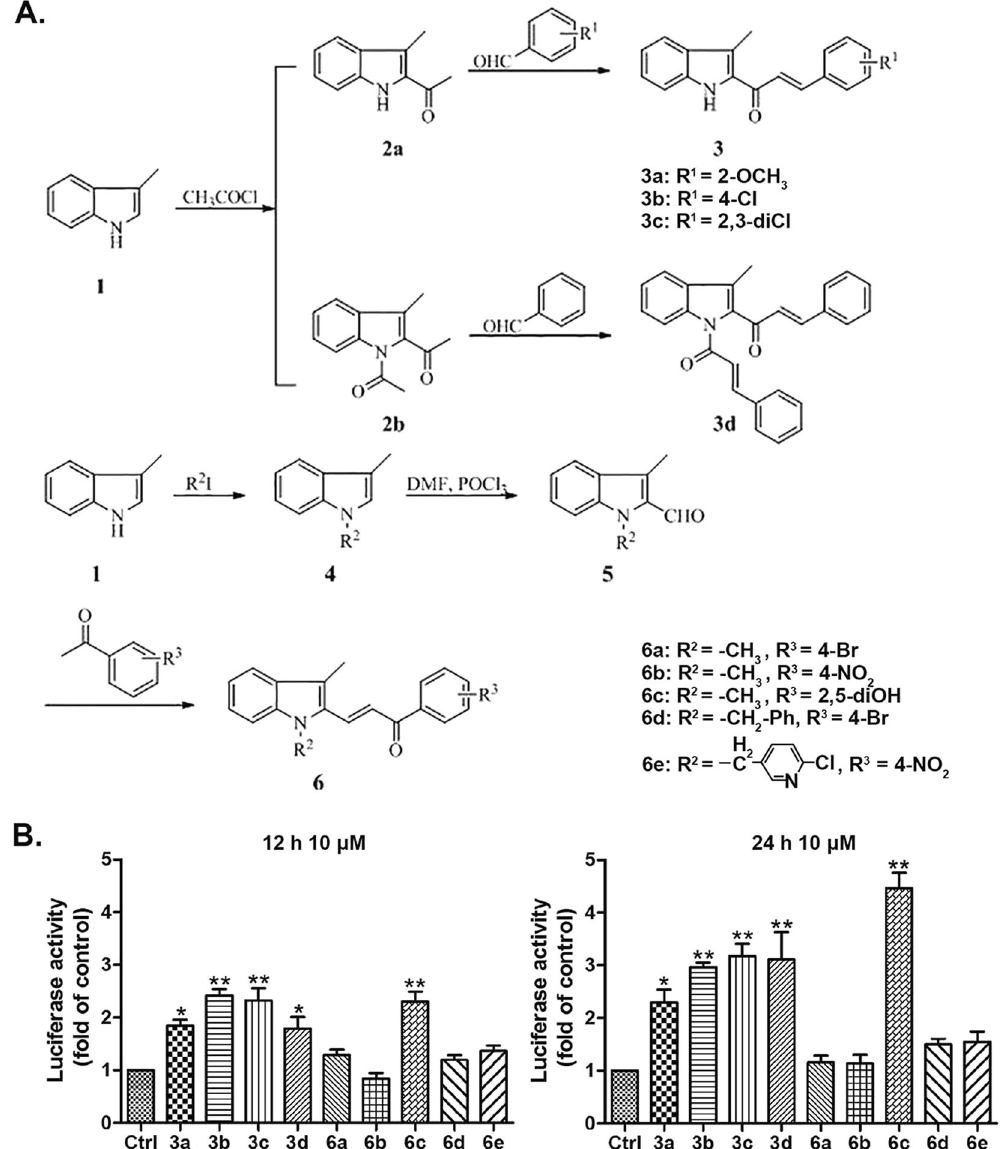
Figure 1. Effects of compounds 3a-3d, 6a-6e on Nrf-2 activity. Chemical structures of compounds 3a- 3d , 6a-6e ( A ). HeLa cells which contain Nrf-2-responsive/pGL4-3 × ARE-basic luciferase reporter vector were treated with compounds 3a- 3d , 6a-6e at 10 μ M for 12 h or 24 h. The control group (Ctrl) was treated with 0.1% DMSO (V/V). Luciferase activity was determined by luciferase assay, and normalized to cell viability measured by SRB assay. Results are mean ± SEM ( * p < 0.05, ** p < 0.01 vs control. N =